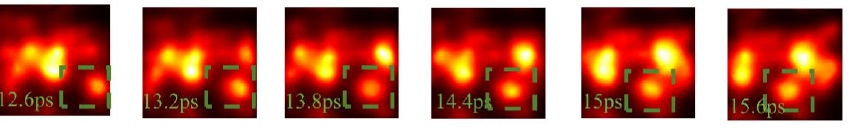
Figure 5. Images of tracking photon centroid.